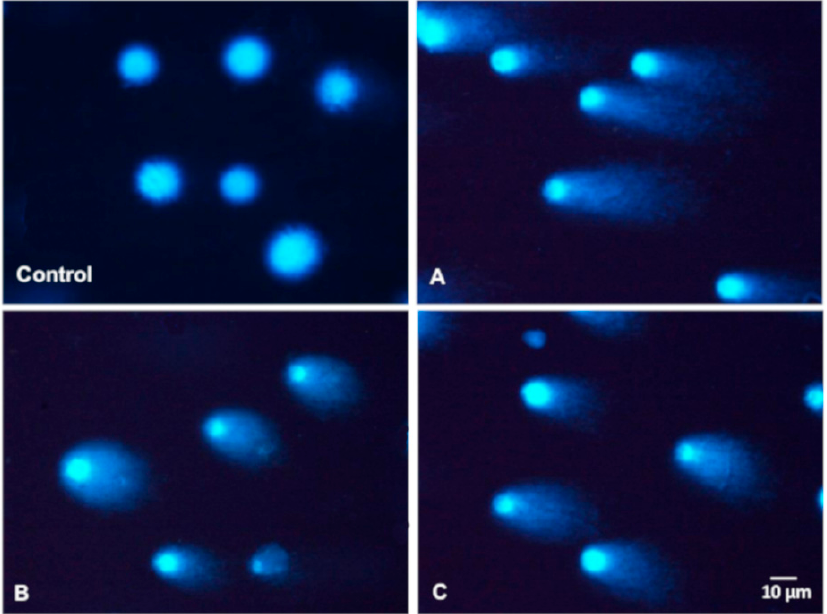
Figure 3. Typical images of DAPI-stained comets exposed to 0.63% leaf extracts: A — Aronia melanocarpa ; B — Cornus mas , C — Chaenomeles superba . Magnification 200 × (Nikon Eclipse, Japan).